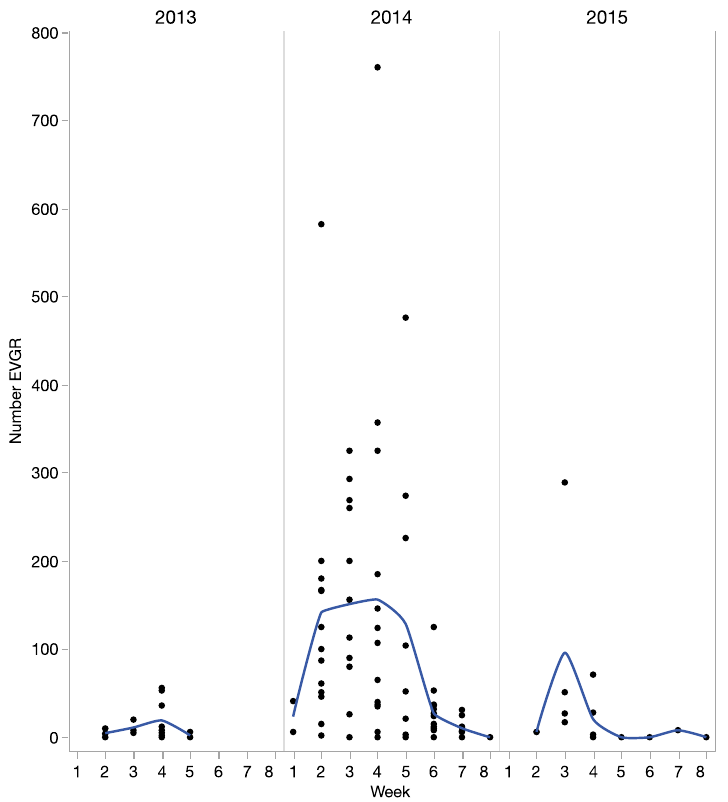
Figure 1. Numbers of Evening Grosbeaks detected during each survey of four sampling zones on the Oregon State University, Corvallis, campus, 2013–2015. Surveys began each year on 11 April (week 1) and extended for 8 weeks through May. Lines are Savitzky–Golay-fitted means [14] implemented with JMP [15].